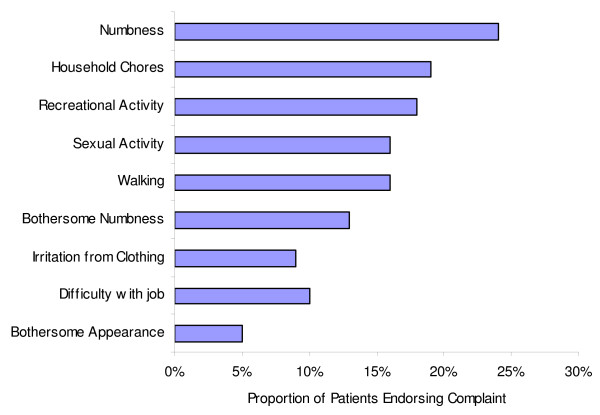
Proportion of follow-up patients endorsing ICGB-related symptoms. At a mean of greater than 3 years following surgery, a relatively large percentage of patients continued to report being troubled by harvest site scar appearance (5%), numbness (24%), and bothersome numbness (13%). In particular, chronic harvest site pain resulted in difficulty with household chores (19%), recreational activity (18%), walking (16%), sexual activity (16%), their job (10%), and irritation from clothing (9%).